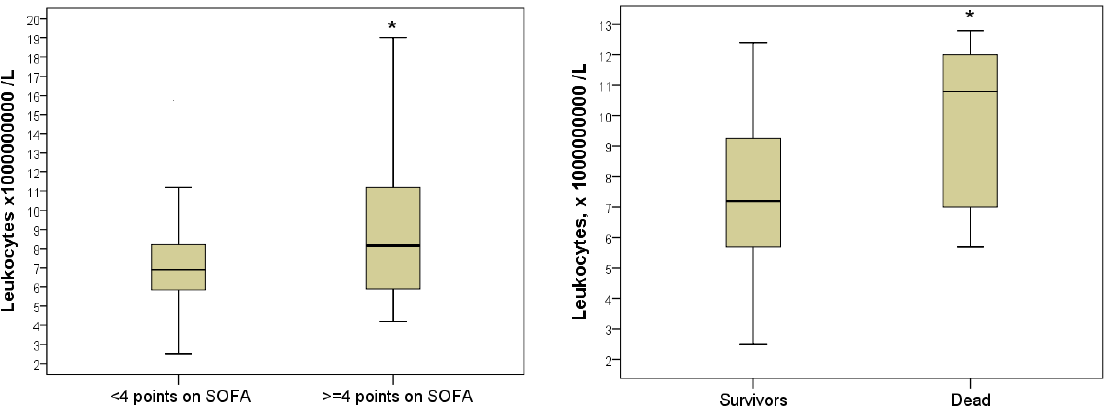
Figure 6. The number of blood leukocytes in hospitalization of severe and mild patients and in patients with favorable and unfavorable hospital outcome (*—the difference between the two groups according to the Mann – Whitney criterion at p < 0.05).